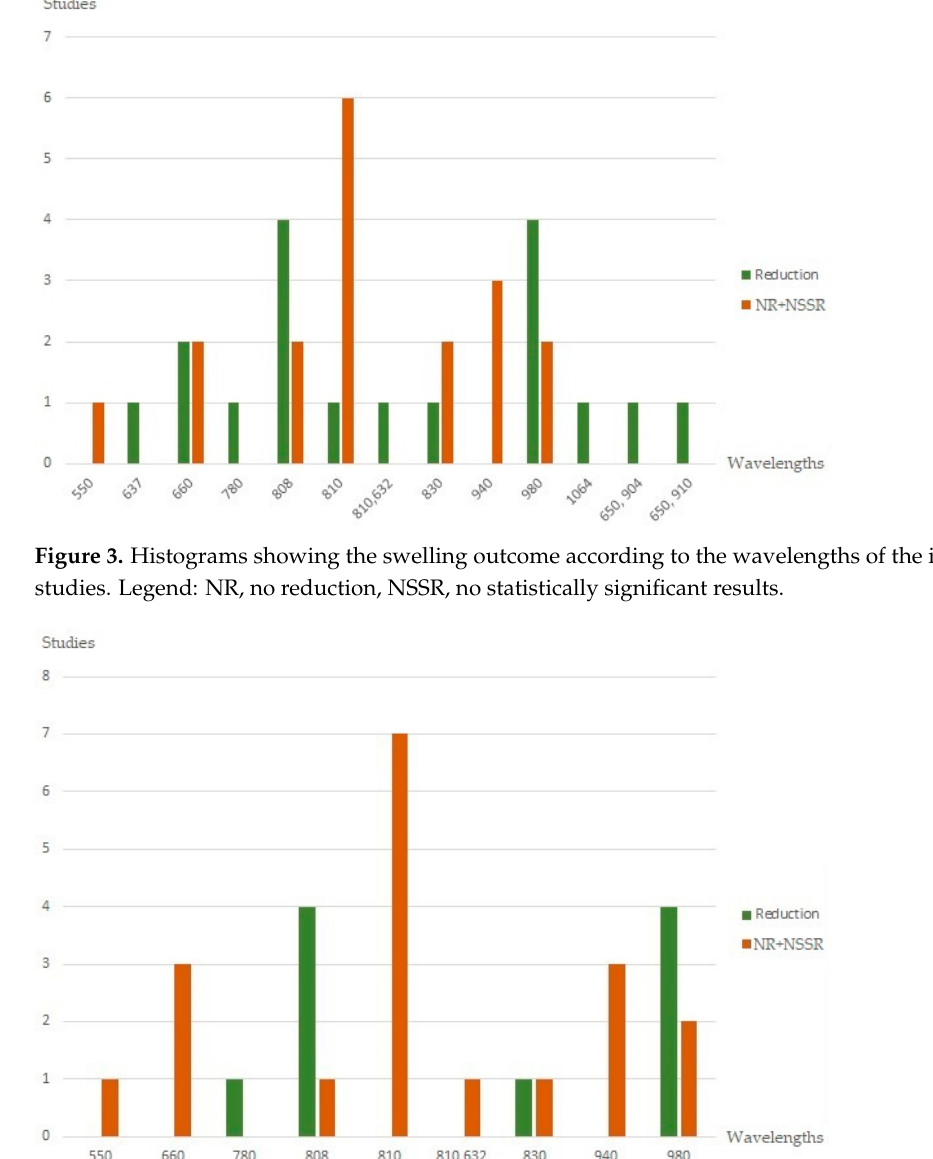
Figure 4. Histograms showing the trismus outcome according to the wavelengths of the included studies. Legend: NR, no reduction, NSSR, no statistically significant results.